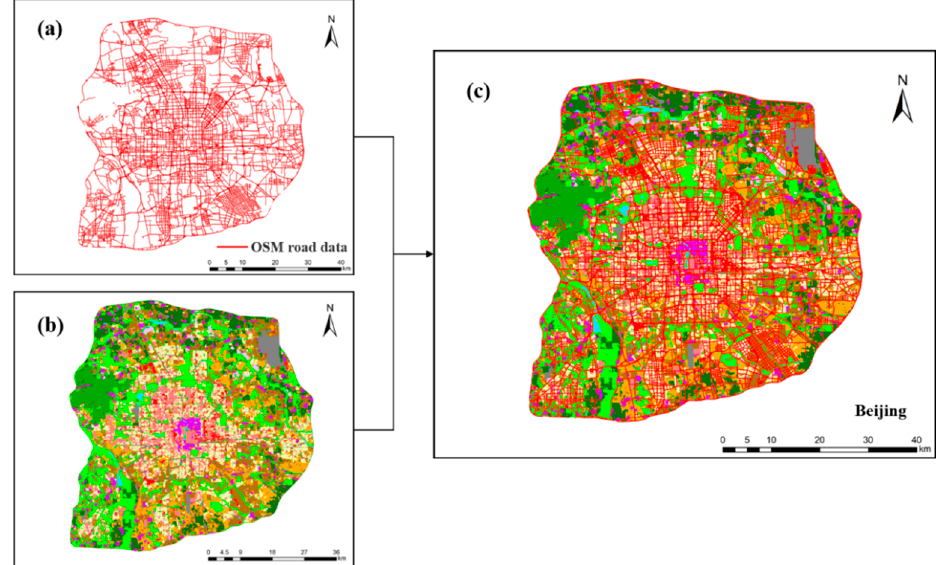
Figure 10. Connected urban functional zone are automatically divided. ( a ) OpenStreetMap road data, ( b ) urban functional zone data, and ( c ) data fusion used for automatic segmentation.